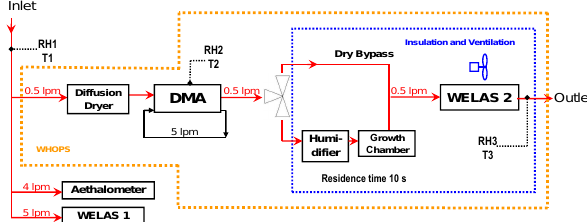
Figure 1. Setup of the PSI-Zeppelin rack containing the WHOPS along with an aethalometer and the WELAS1 sharing the sampling line in configuration for the airborne measurements. The positions of the RH and T sensors are shown (RH1, T1,